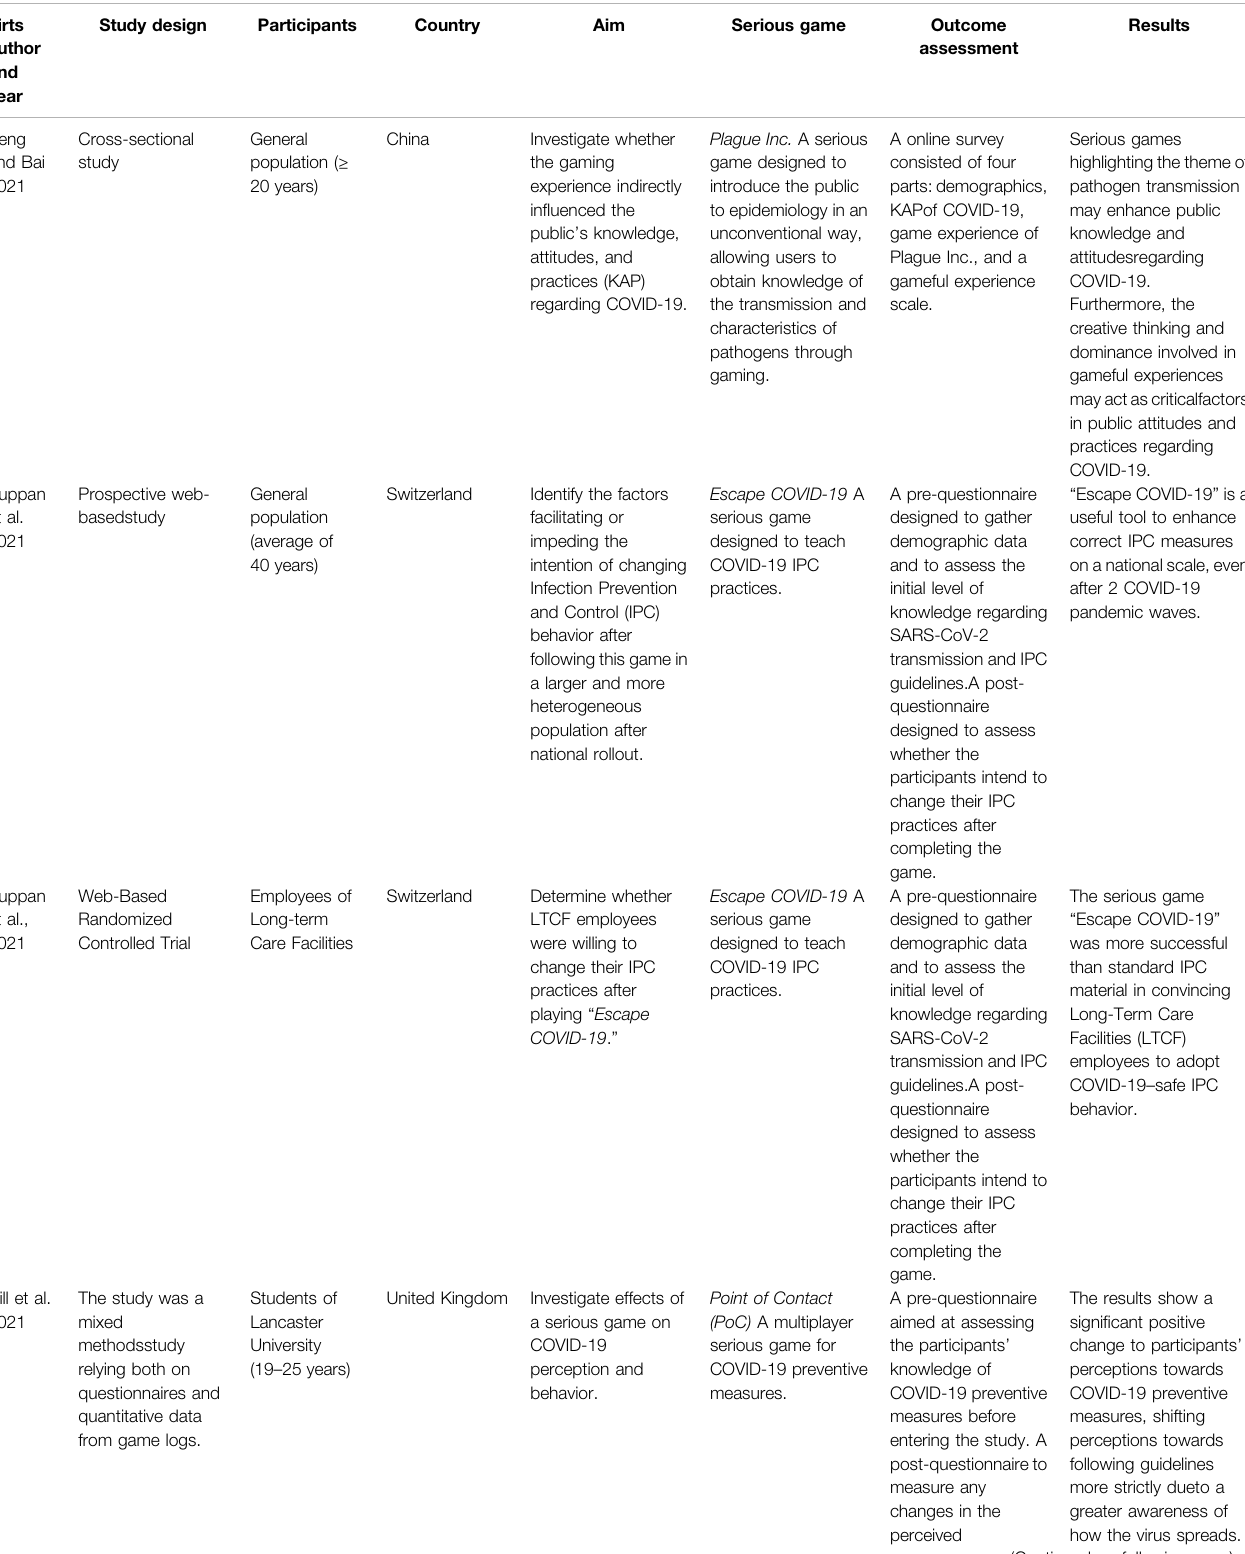
TABLE 1 | Studies